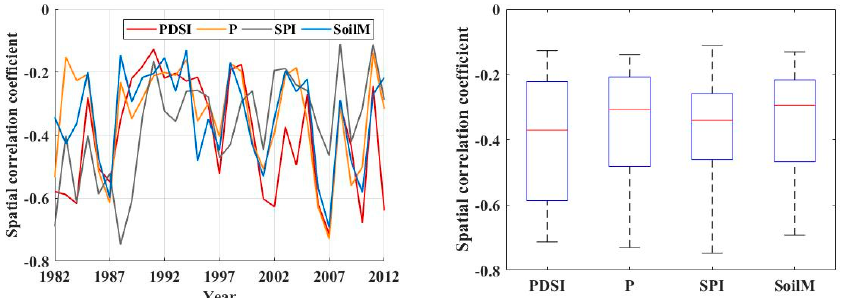
Figure 11. Coefficient of spatial correlation between monthly maps of EDI and other drought indices for 1982–2012. Boxplot depicts median, 25% to 75% range (box) and 10% to 90% range (whiskers).